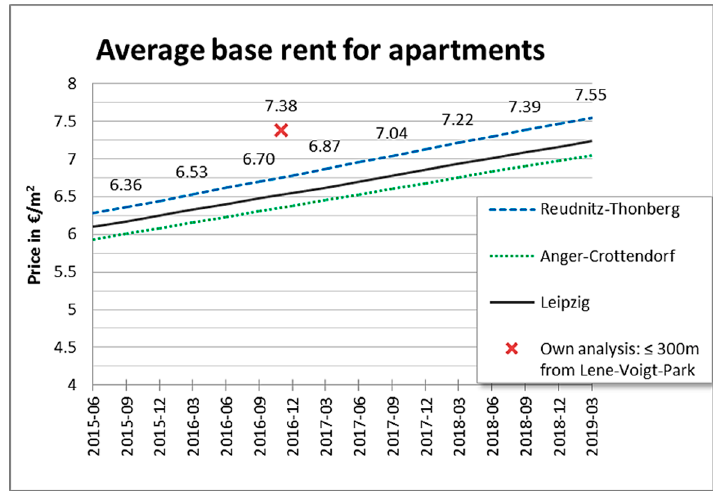
Figure 6. Rental prices for advertised apartments at the city, district, and neighborhood levels. (Data labels shown for Reudnitz-Thonberg and neighborhood level only; data sources: [89,91]).